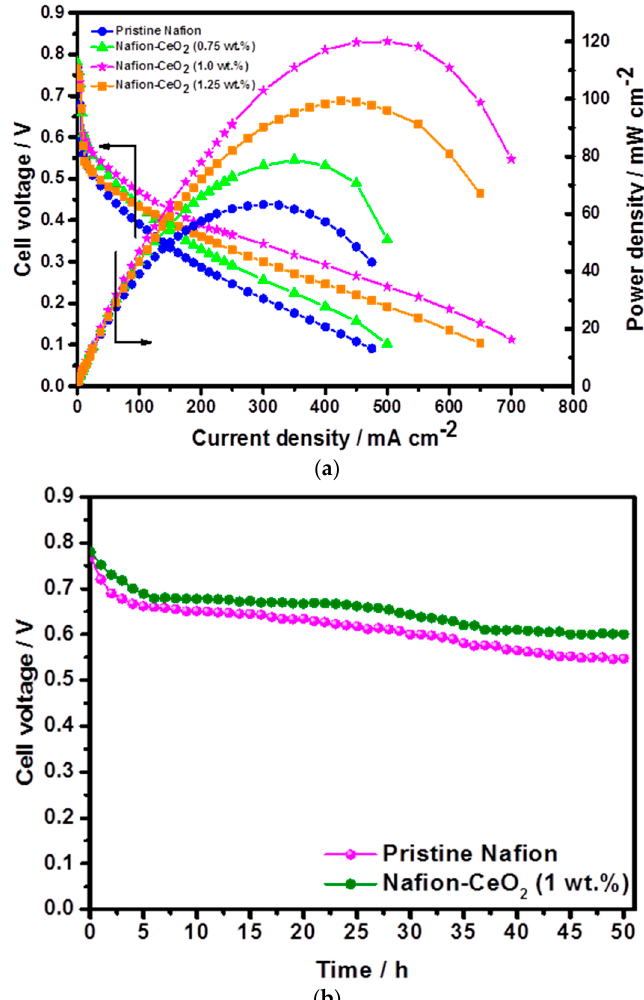
Figure 7. ( a ) DMFC performances of pristine Nafion and Nafion-CeO 2 composite membrane at 70 °C under ambient pressure; ( b ) Stability test of the pristine Nafion and Nafion-CeO 2 (1 wt. %) membranes for 50 h under OCV condition.